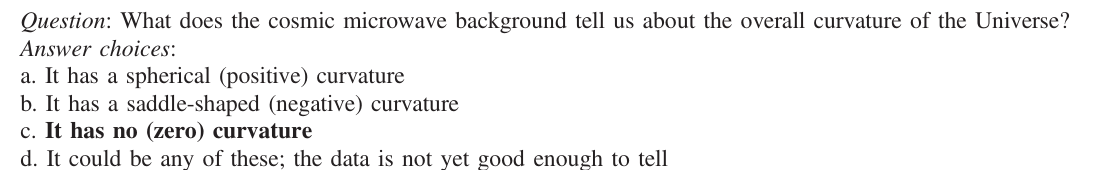
TABLE III. Postinstruction exam question ( N ¼ 75